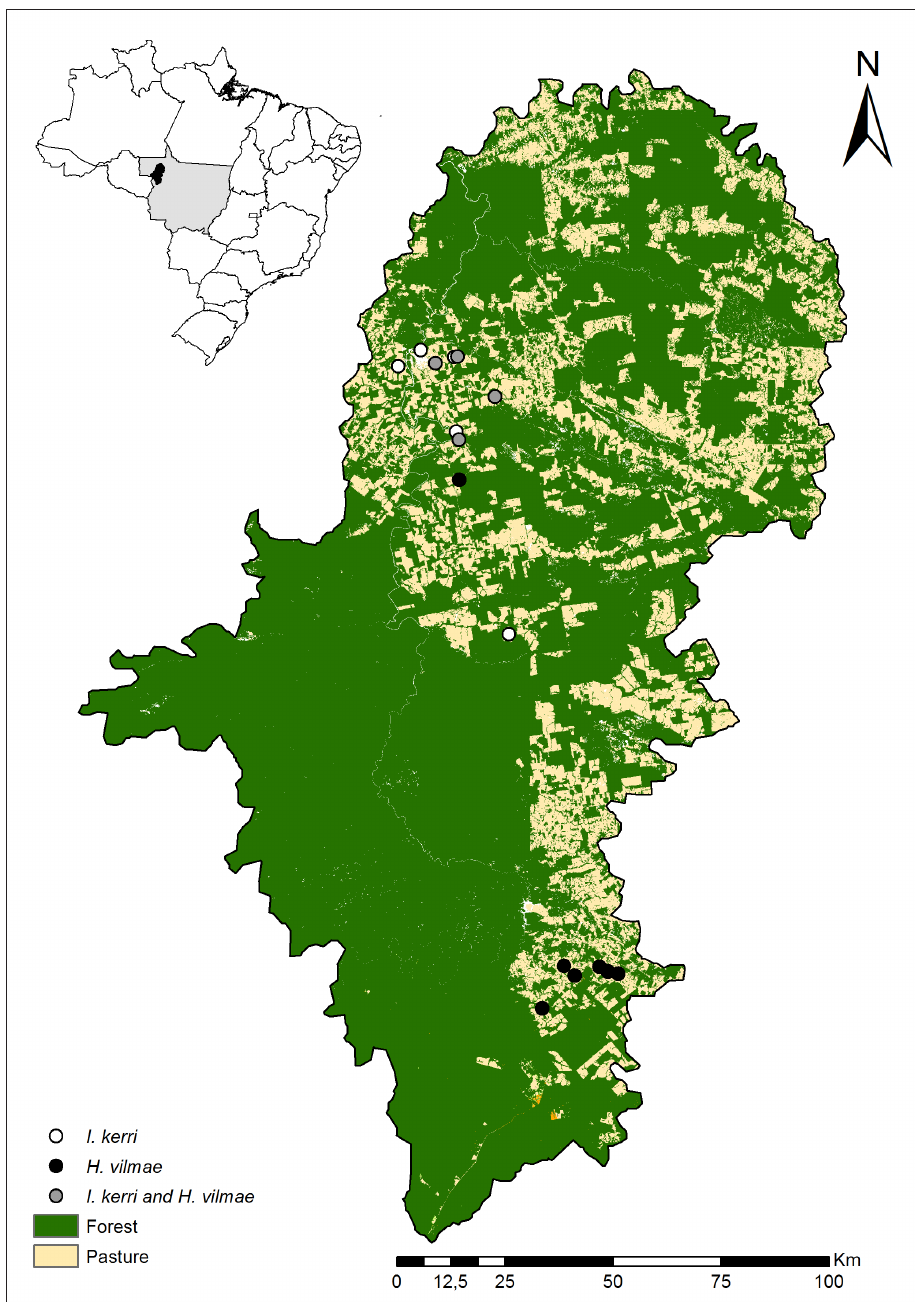
FIGURE 2 | Location of the sampled streams in the Aripuanã River basin, Mato Grosso State, Brazil. White circles represent streams with Inpaichthys kerri , black circles represent streams with Hyphessobrycon vilmae , and gray circles represent streams with both